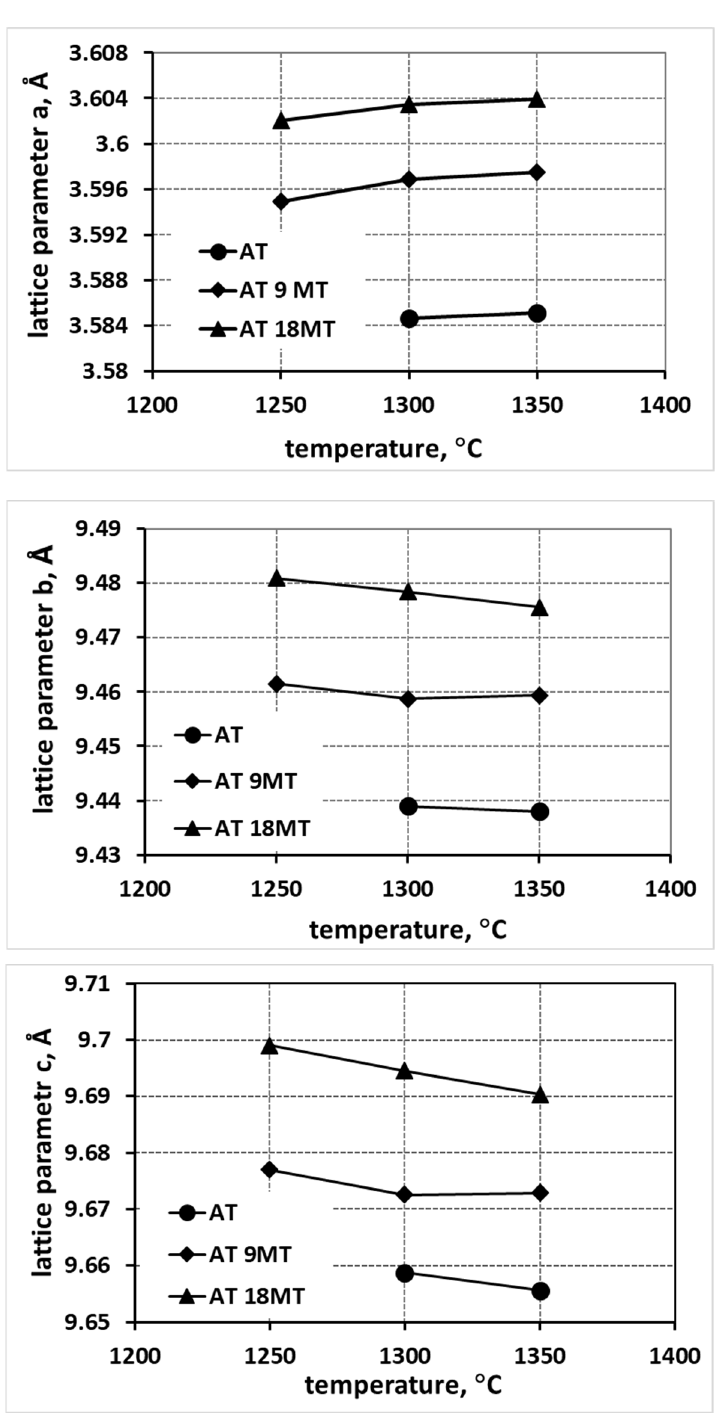
Figure 4. Comparison of changes in lattice parameters of tialite elementary cell and its solid solutions in systems stabilized with different amounts of MgTi 2 O 5 and tialite without stabilizers (AT).